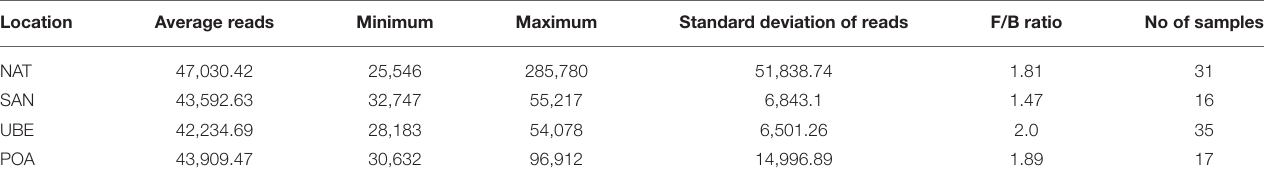
TABLE 1 | Number of subjects and sequencing statistics by geographical region and Firmicutes/Bacteroidets ratio.